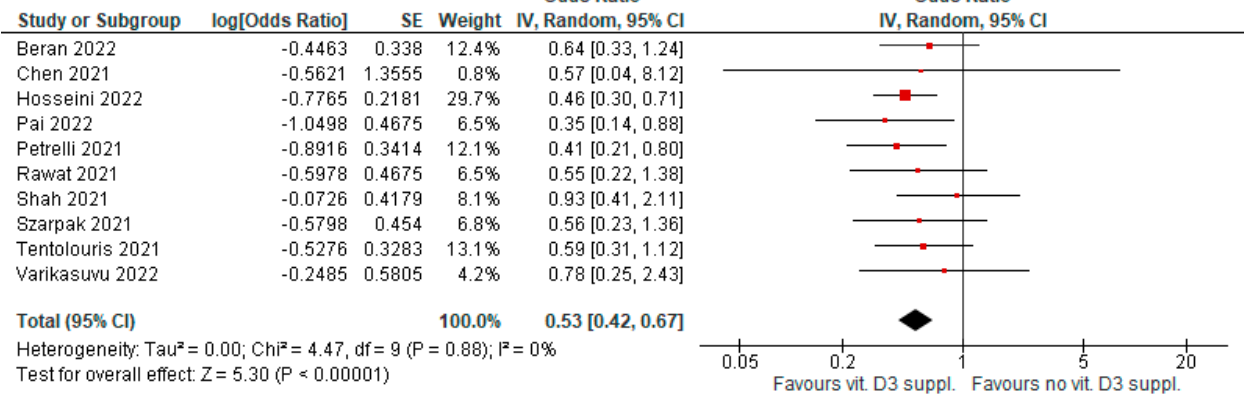
Figure 6. Forest plot showing results for the association of vitamin D3 supplementation and COVID- 19 mortality.